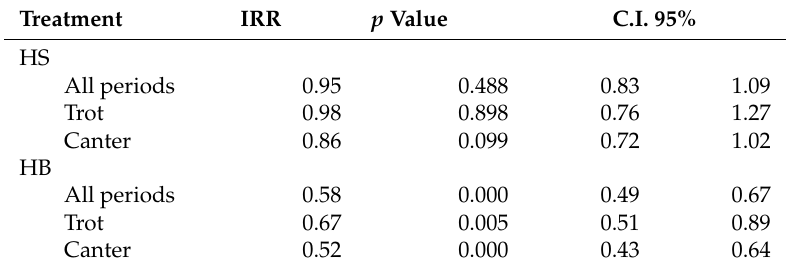
Table 2. Effect of treatment and period on incidence rate ratio (IRR) of median headshakes/minute across all times. IRR, p value and confidence intervals. p < 0.05 was considered significant.